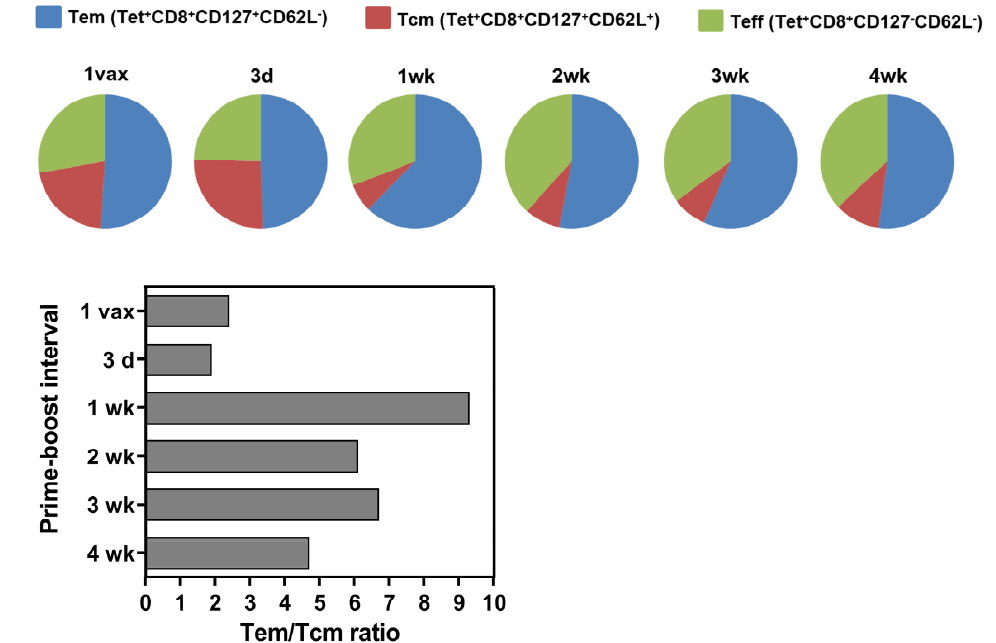
Figure 4. Longer prime-boost interval regimens generate a higher frequency of effector memory T cells. HPV16 E7 (49–57) peptide specific T cells identified by MHC tetramer staining were analyzed for T cell effector and memory phenotype. Splenocytes from immunized mice ( n = 5) were isolated 10 days post boost and stained with E7 tetramer (tet), CD8, CD44, CD127 (IL-7R α ), and CD62L. The percentages of Tem, Tcm, and Teff cell phenotypes were determined after post-analysis Boolean gating on CD3 + CD8 + Tet + T cells. Pie charts show the relative frequencies of effector and memory phenotypes within the tetramer positive population. Mice vaccinated at 4 wk, 3 wk, 2 wk, and 1 wk PBIs exhibited similar percentages of each population and greater numbers of T EM . The ratios of T EM :T CM are shown as bar graphs. T EM , effector memory T cell; T CM , central memory T cell; Teff, effector T cell.